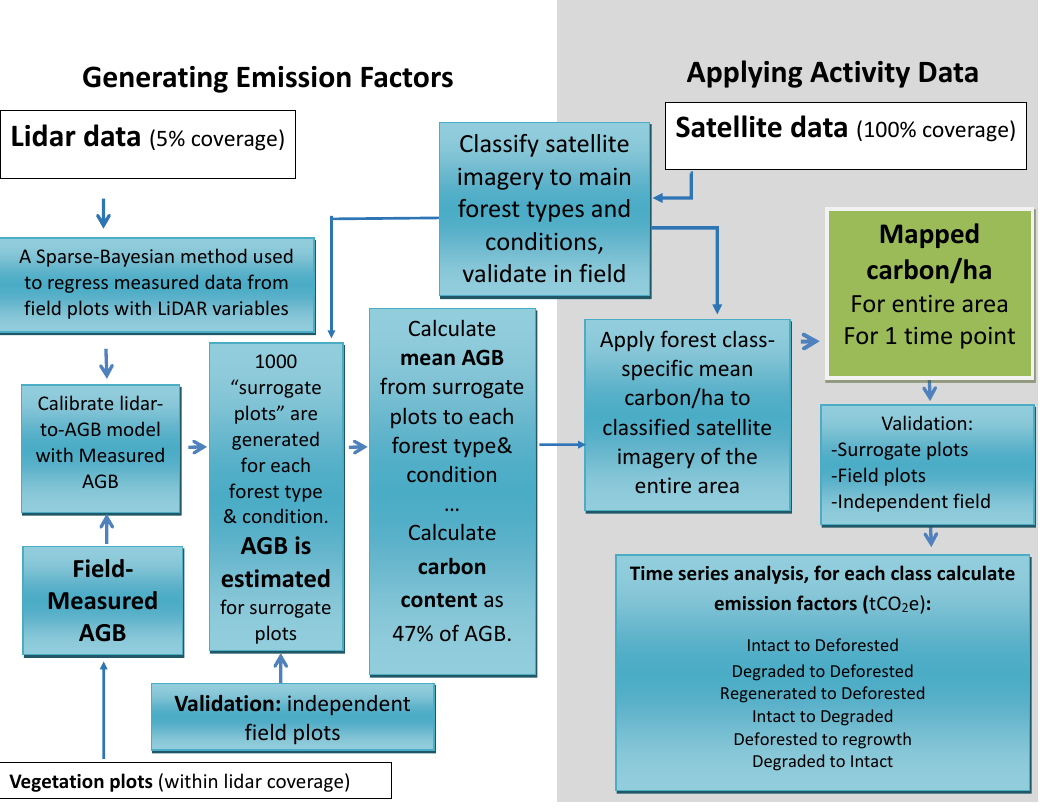
Figure A1. LAMP2 algorithm